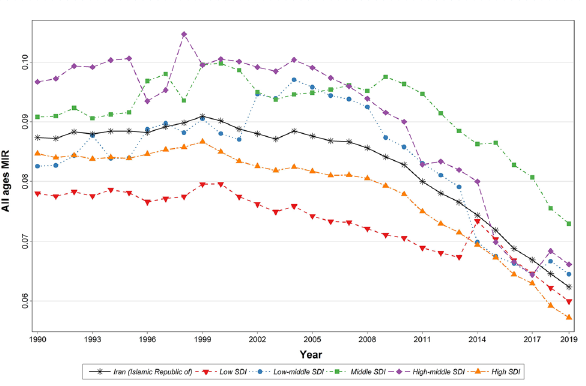
Figure 7. Time trend of all ages MIR due to T1DM by SDI quintiles in the country from 1990 to